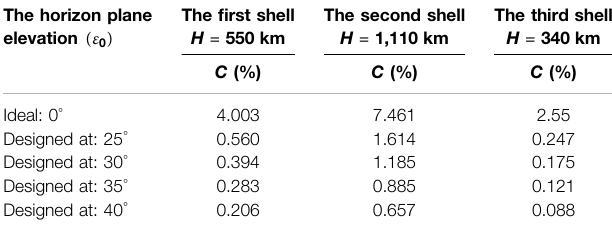
TABLE 5 | Coverage of the Starlink satellites.